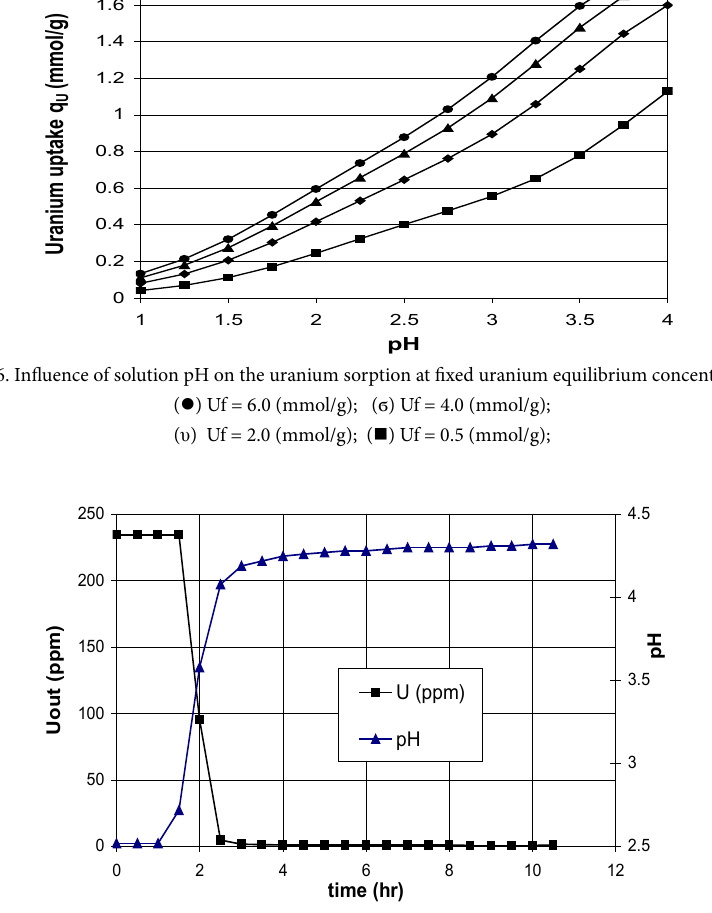
Fig. 7. Response of the column outlet concentration to the step function in the column inlet; F=175 ml/h, V